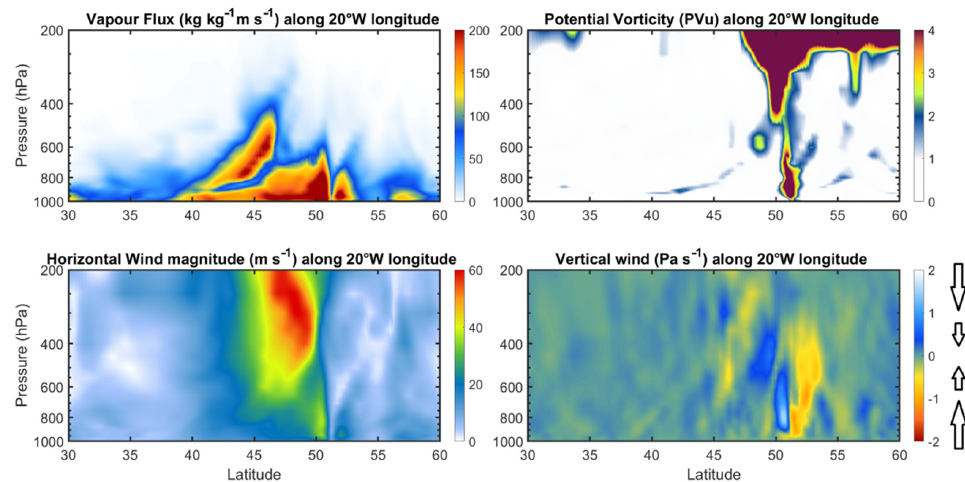
Figure 6. ECMWF ERA5 Cross sections along 20 ◦ W longitude (25 August 2014 at 00 UT) of water vapor flux (kg kg -1 m s − 1 , top left ), PV (PVU, top right ), horizontal wind (m s − 1 , bottom left ), and vertical wind (Pa s − 1 , the correspondence between sign, colors, and direction of the vertical wind is given with the color bar, bottom right ).